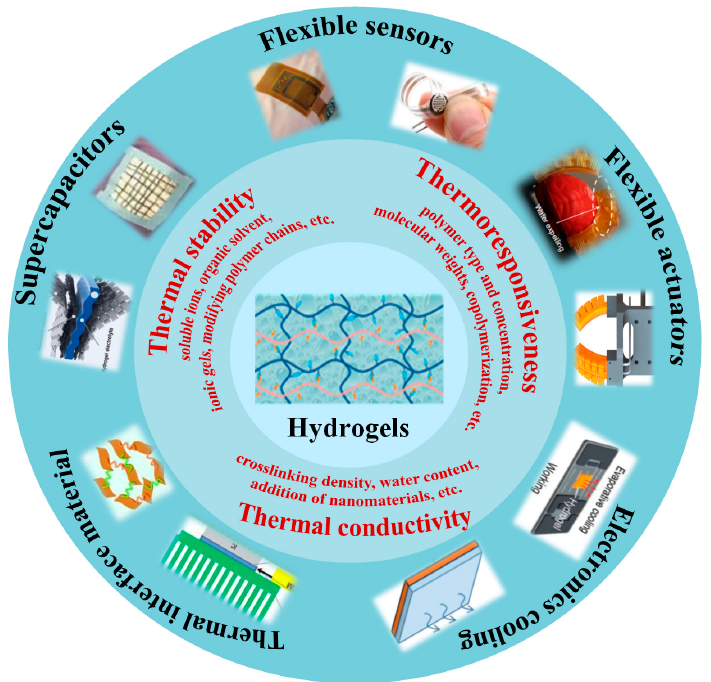
Figure 1. Main thermal characteristics and applications of hydrogels in electronics.